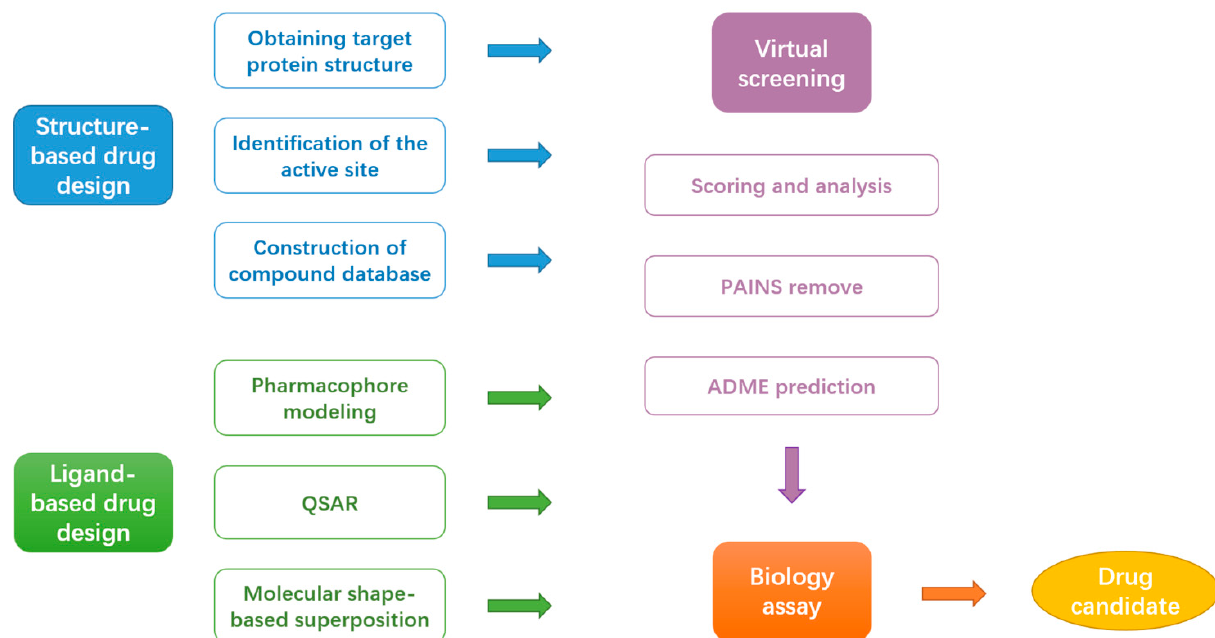
Figure 1. Flow chart of commonly used computer-aided drug design (CADD) approaches.